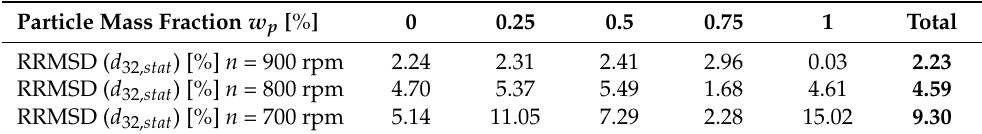
Figure 10. ( a ) Comparison between experimental (circles) and simulated (crosses) Sauter mean diame- ter for different stirrer speeds ( n = 700,800,900 rpm) in steady state ( t = 900 s), ( b ) simulations (lines) in comparison with experimental data (symbols) of the volume based density function q 3 in steady state ( t = 900 s) for w p = 1% with a variation of stirrer speed. Simulations were performed with free parameters summarised in Table 1 and modified coalescence efficiency according to (Equation (12)). Table 2. Relative root-mean-square deviations in percent between experimental and simulated steady- state Sauter mean diameters, by variation of stirrer speed n and particle mass fraction w p . For each stirrer speed, the total RRMSD for all 5 particle mass fractions is also